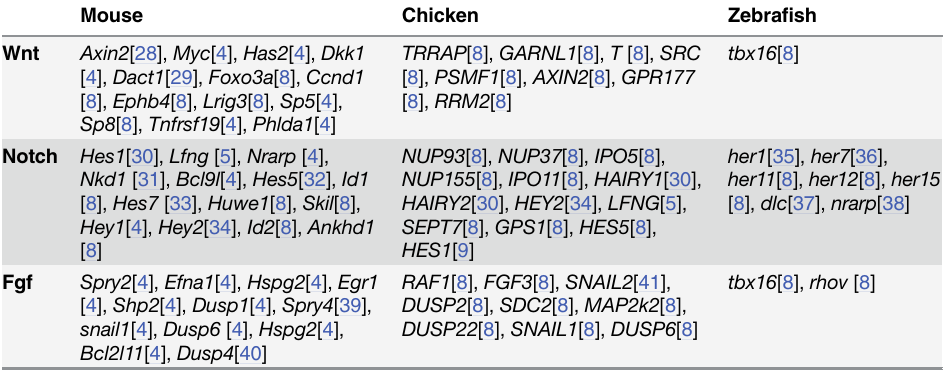
Table 3. Published cyclic genes of mouse, chicken and zebrafish somitogenesis used for motifs enrichment. We considered cyclic genes in the same pathway as co-regulated and used their sequences for cis-regulatory elements finding. Moreover, as somitogenesis is better described in mouse that any other spe- cies, mouse sequences are used for de novo motif finding and the subsequent motifs were used for enrich- ment analysis in chicken and